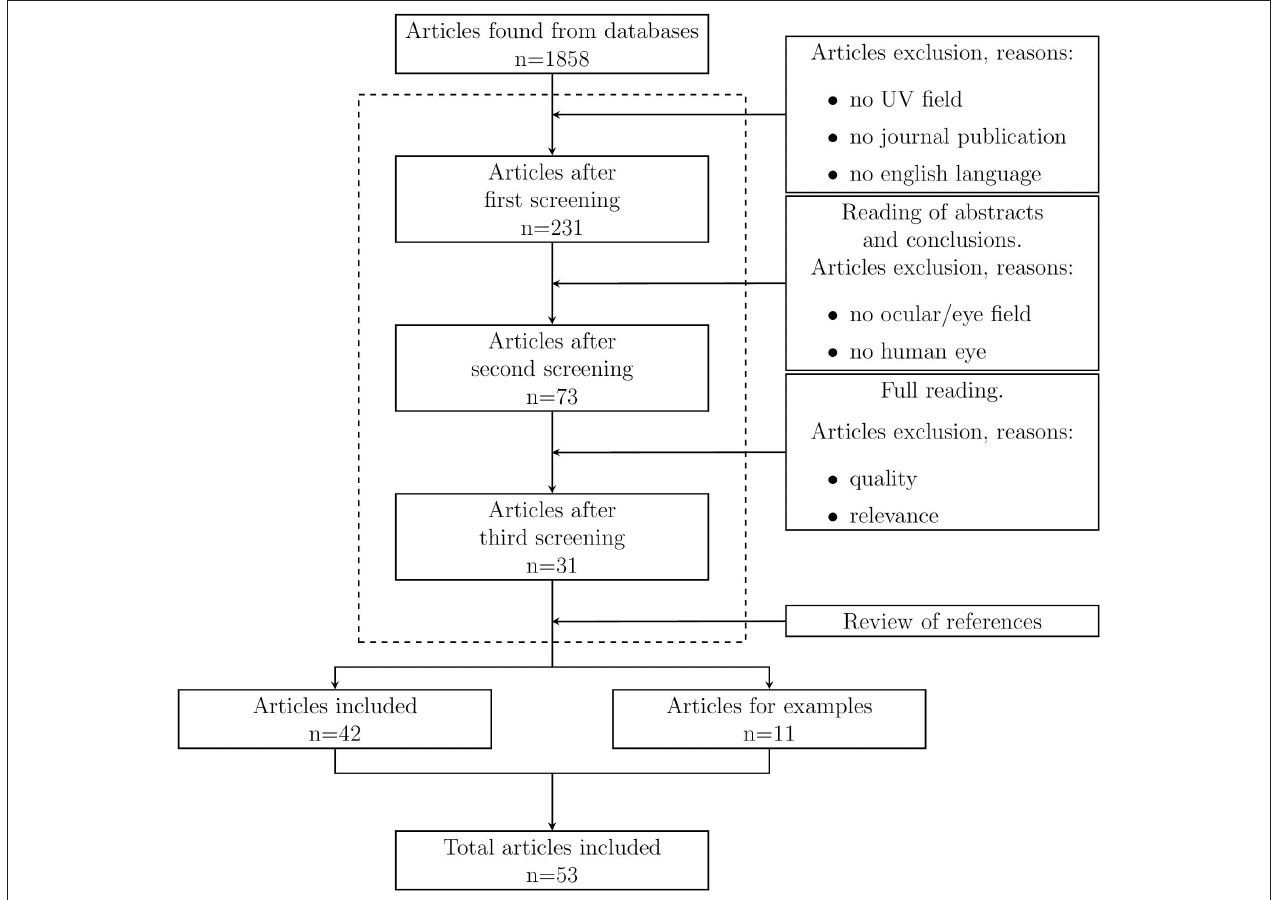
FIGURE 1 | Flow diagram of the review process performed in this